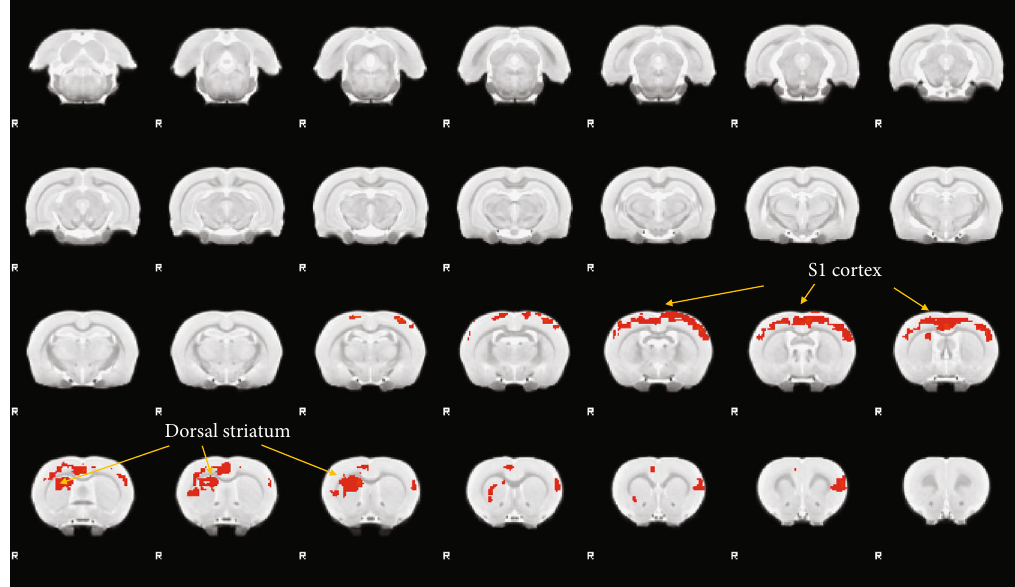
Figure 4: Brain functional reorganization analysis of the primary motor cortex (M1) after nerve repair. We performed a seed-based whole- brain functional connectivity (FC) analysis of the contralateral primary motor cortex (M1) between the nerve repair and the nerve injury groups (repair-injury). The rat contralateral M1 cortex (left) demonstrated an extensive FC reorganization (marked in red) with bilateral sensory cortex (S1) as well as right dorsal striatum (dS) at week